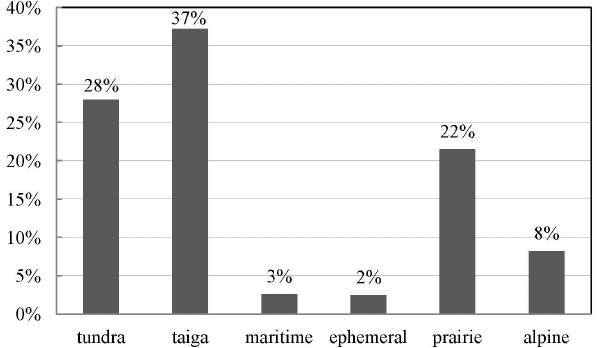
Fig. 2. Percentage of snow cover area for six snow classes across the former